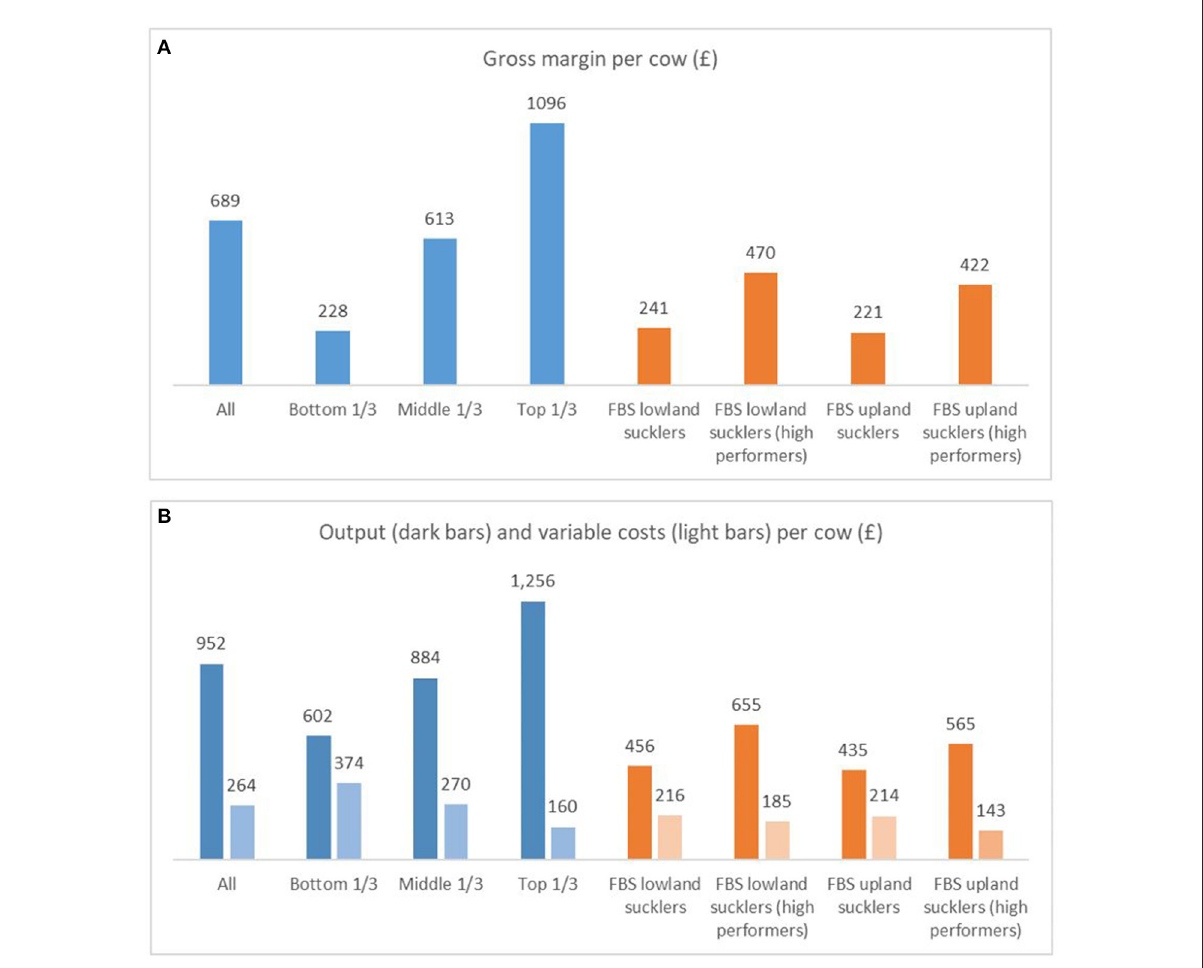
FIGURE2 Economic performance of PFLA beef sucker enterprises (blue) compared to Farm Business Survey data (orange) for the same year, (A) gross margins per suckler cow, (B) output and variable costs per suckler cow. All values are in £, specific values are given at the top of each bar.